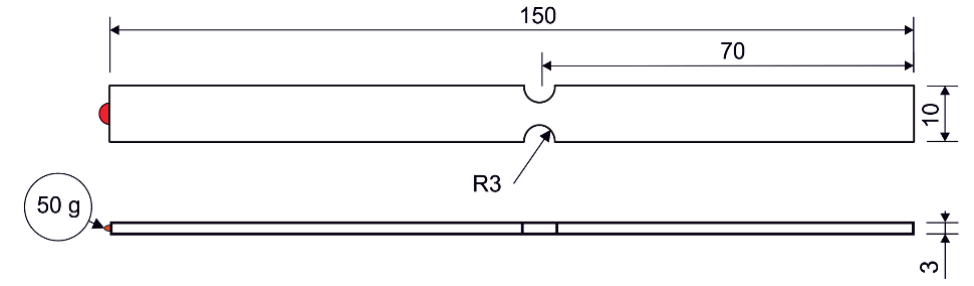
Figure 12. Specimen used in numerical simulation.